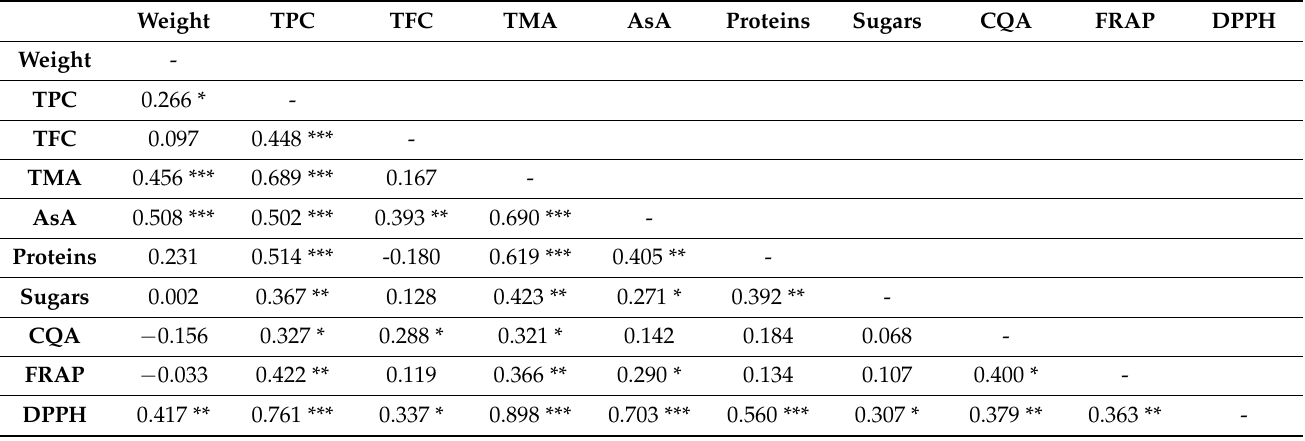
Table 2. Correlation coefficients and levels of significance among the physicochemical parameters studied.